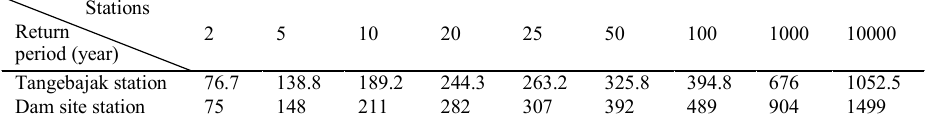
Table 3: Designing flood of Gavi River for various return periods (m 3